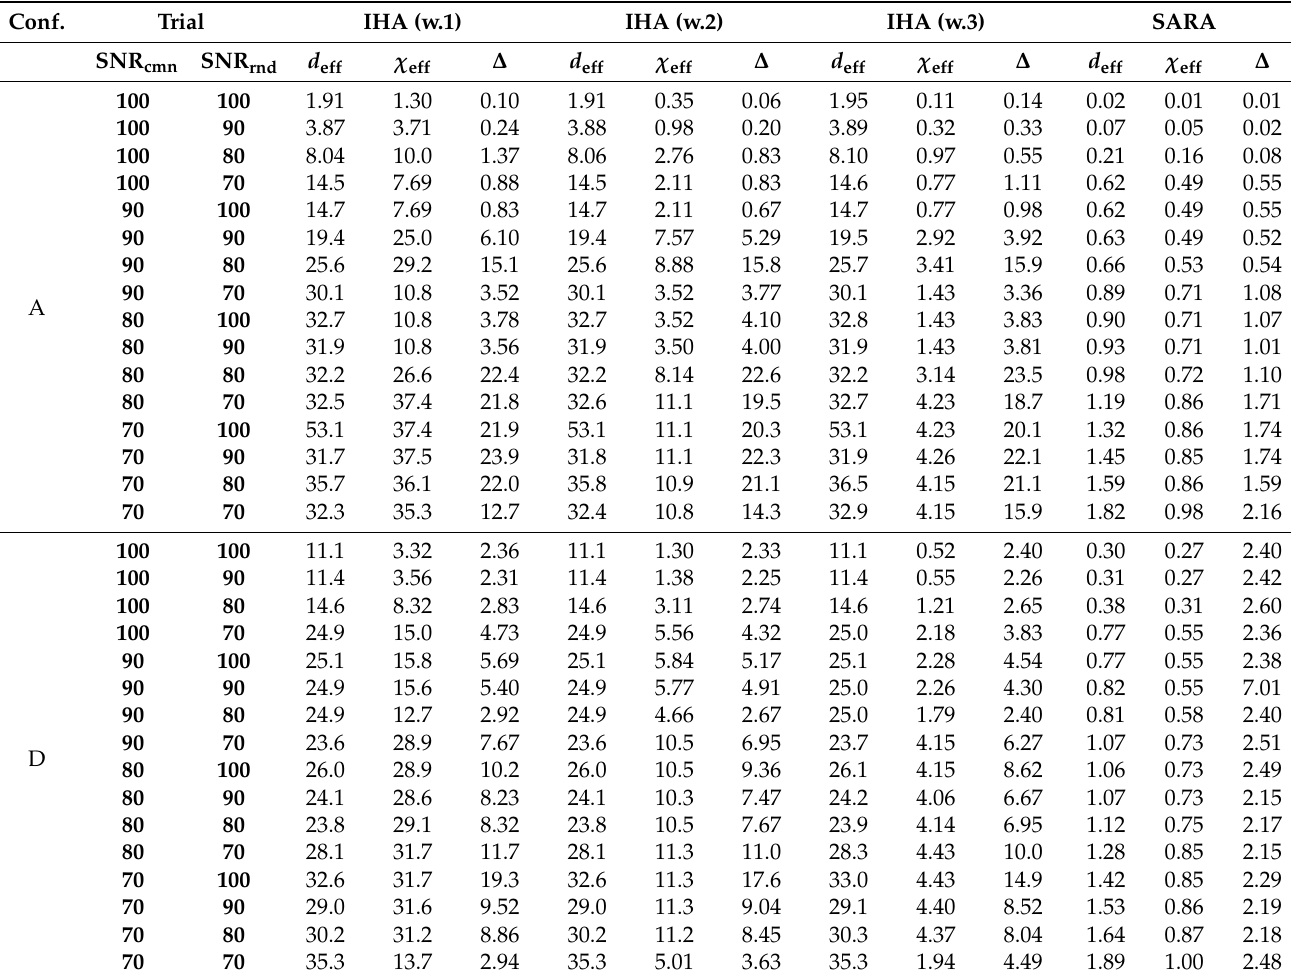
Table A4. Dispersion parameters ( d eff , in mm, and χ eff , in deg) and rms distance ( ∆ , in mm) between exact and estimated AoRs for different common (SNR cmn ) and random (SNR rnd ) signal-to-noise ratios (in dB) of the corresponding sources of noise signals. Results are given for A and D motion